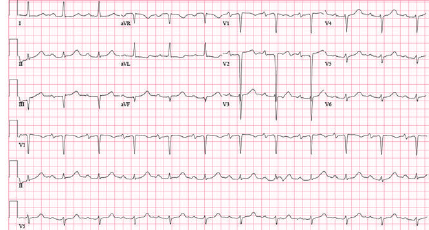
Figure 3: One week into admission after discontinuation of hydroxychloroquine and treatment with mexiletine 150 mg